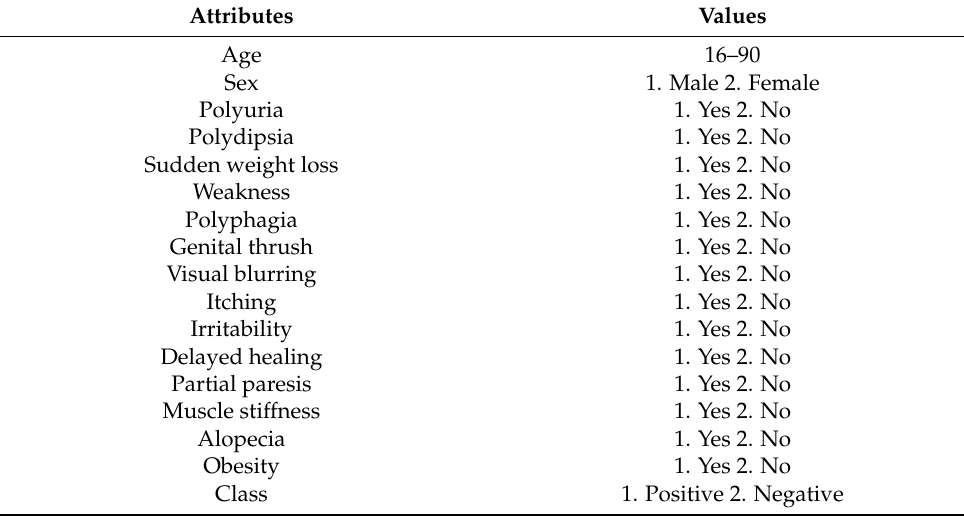
Table A2. Attributes and value of early-stage diabetes risk prediction dataset published by